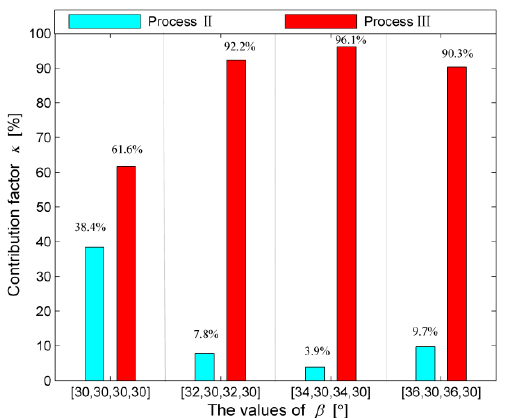
Figure 10. Contribution factor diagram of Processes II and III to the combination effect under different β .